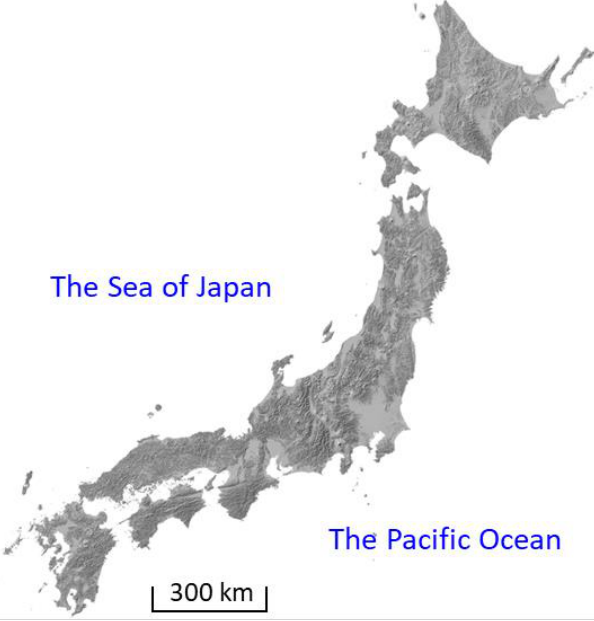
Figure 1. Shaded relief map of main part of Japanese